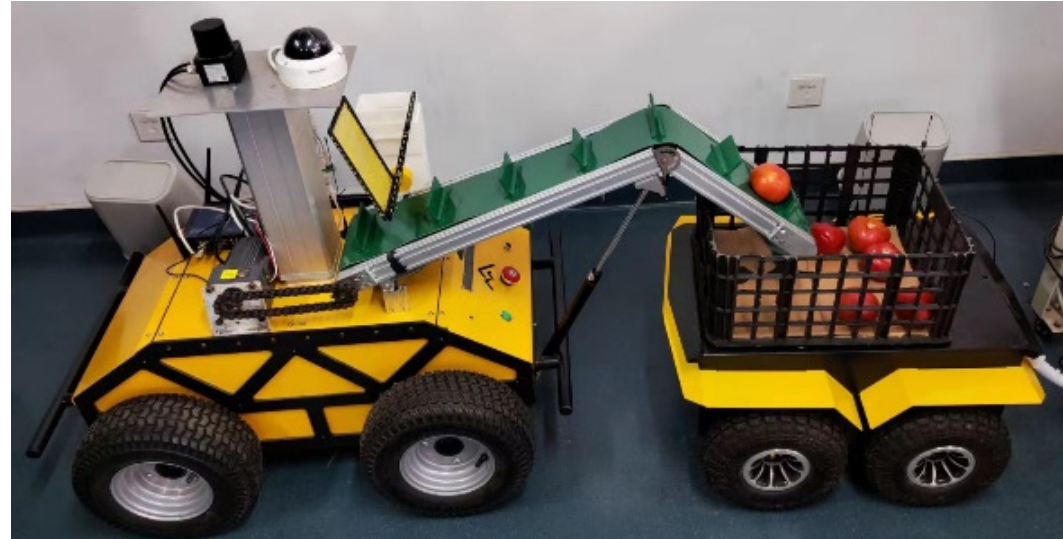
Figure 13. Prototype test of post-harvest collection device.